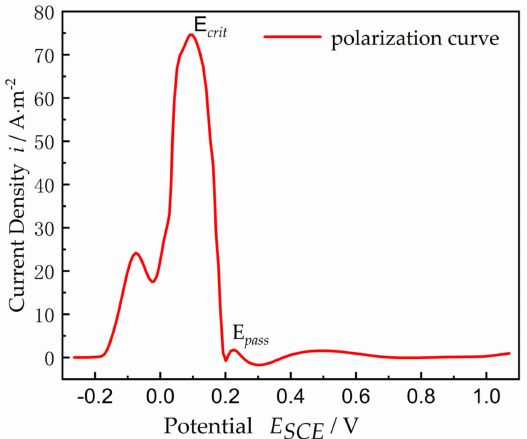
Figure 2. Polarization curve for Ni electrode in sulfuric acid along the active-to-passive direction from Brackman [33], indicating the critical potential, E crit = 0.108 V, and passive potential, E pass = 0.20